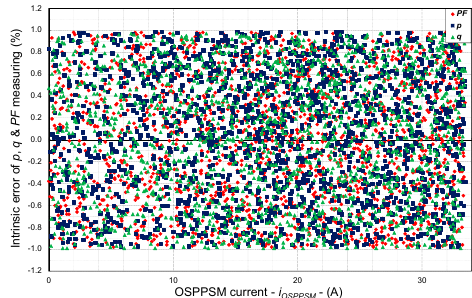
Table 5. Current magnitude distortion test: maximum intrinsic error (%), MAPE (%), MRE (%), and standard deviation (%): voltage variation.